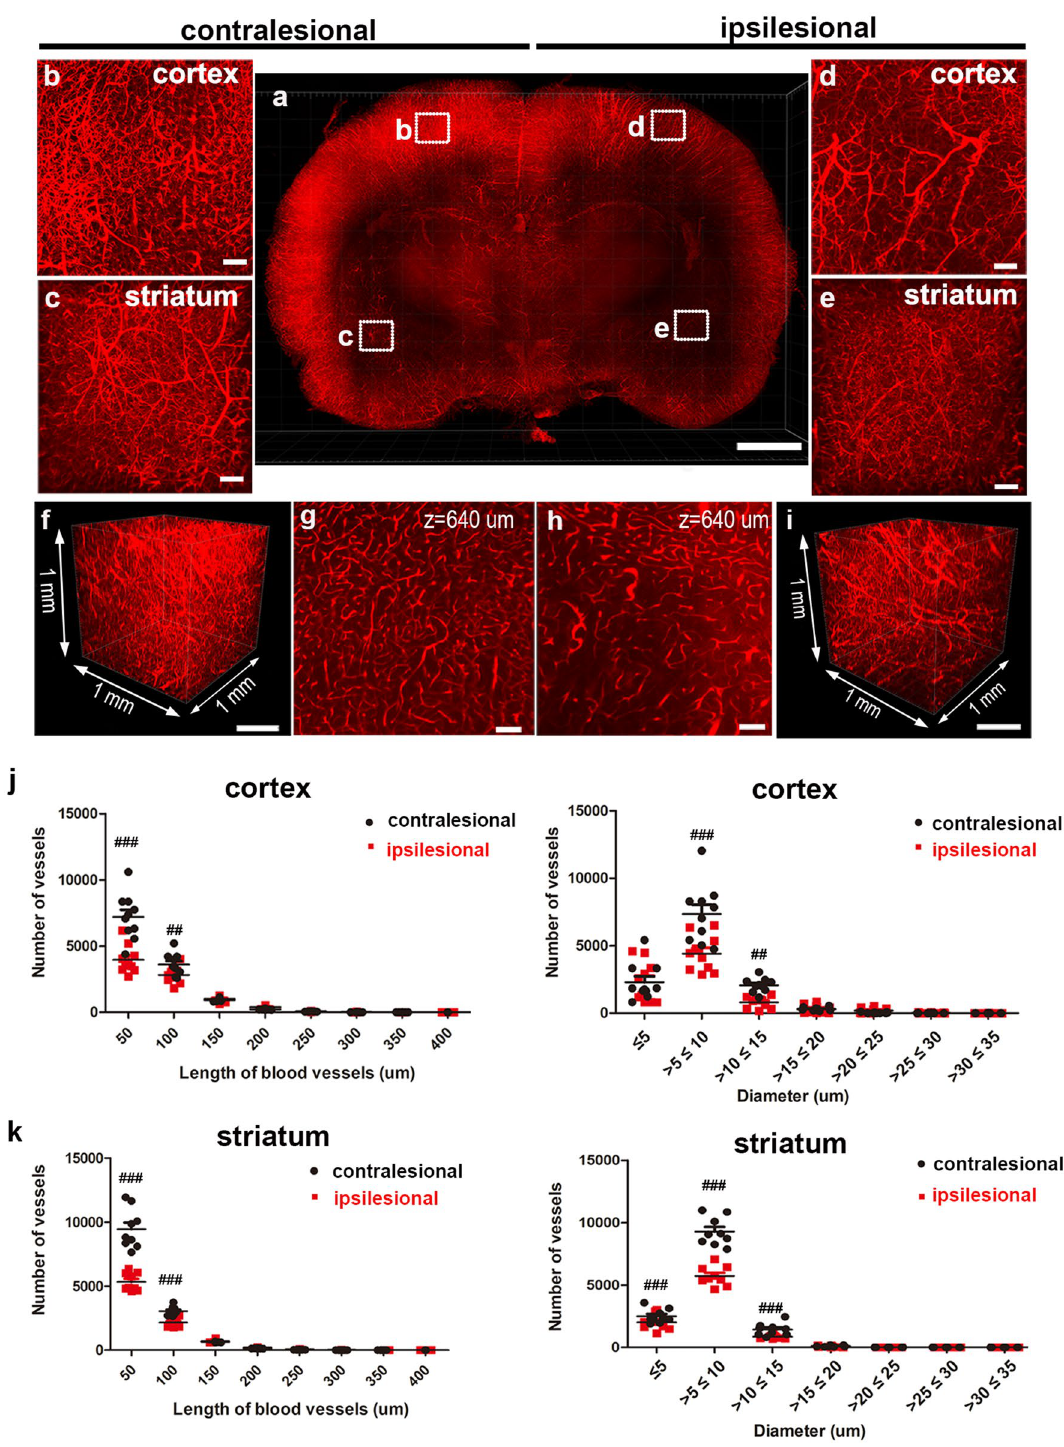
Figure 2. 3D visualization of the vasculature in rat brain of MCAO model after tissue clearing. ( a ) 3D reconstruction of the vasculature in the 3-mm-thick rat brain slice stained with lectin. Images were obtained from LSFM equipped with a 5× objective. ( b – e ) Higher-magnification view of XY plane of the boxed region (cortex and striatum, imaging volume were 1 mm × 1 mm × 1 mm) in ( a ) are shown. ( b , c ) Maximum projection (z-stack) images of the contralesional cortex and striatum. ( d , e ) Maximum projection (z-stack) images of the ipsilesional cortex and striatum. ( f , i ) 3D reconstructions of the cortical region in ( b , d ) are shown. ( g , h ) Images at random depths of the brain slice from ( f , i ) are shown (Z = 640 μm relative to the top imaging surface). ( j , k ) Quantification of length and vessel diameter in 3–4 cortical and striatal fields of view per slice (n = 3 animals). Plots in ( j ) and ( k ) show means ± SEM values. Two-way ANOVA, FDR multiple comparison test, ### p < 0.001, ## p < 0.05. Scale bar = 2 mm in ( a ), 100 μm in ( b – e , g , h ), 300 μm in ( f , i